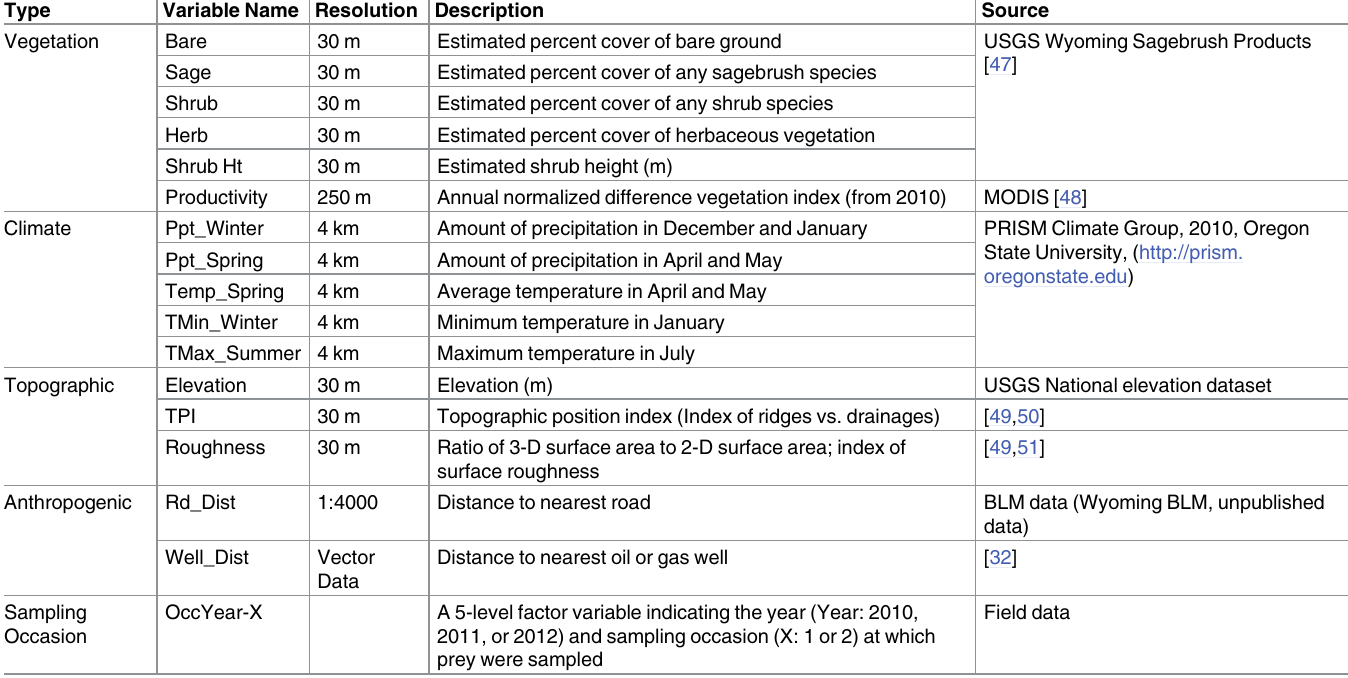
Table 1. Variables considered for use as covariates of small mammal prey density in the shrub-steppe and grassland regions of Wyoming, 2010–